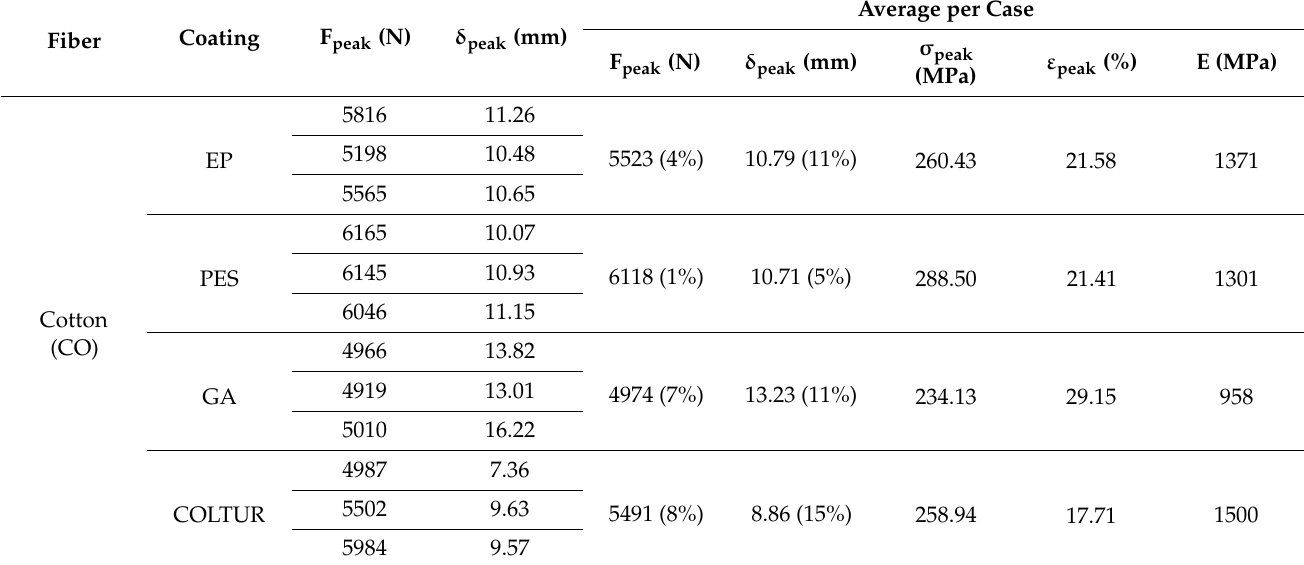
Table 7. Cotton meshes’ tensile test results.